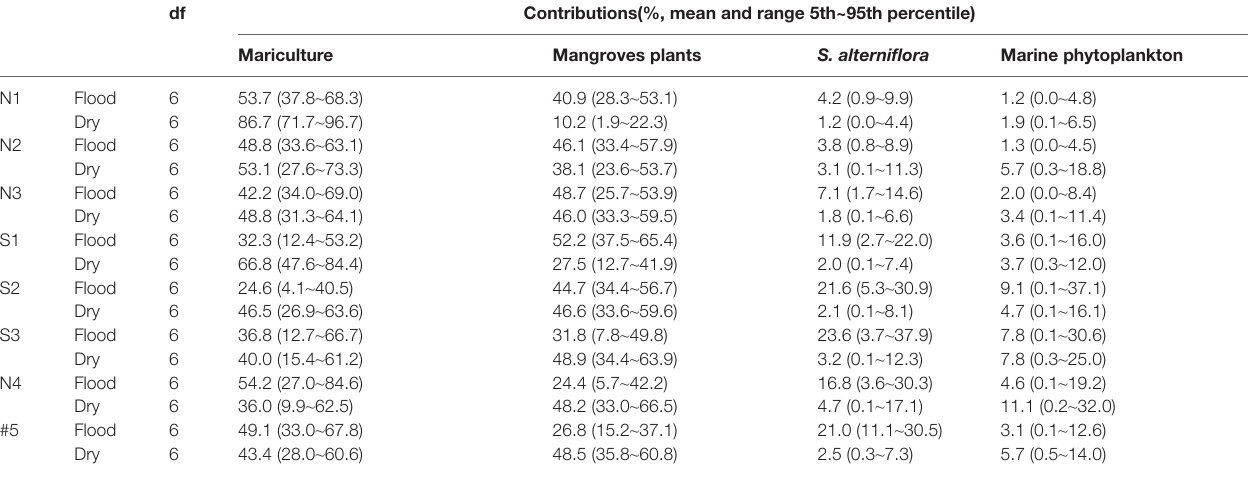
df Contributions(%, mean and range 5th~95th